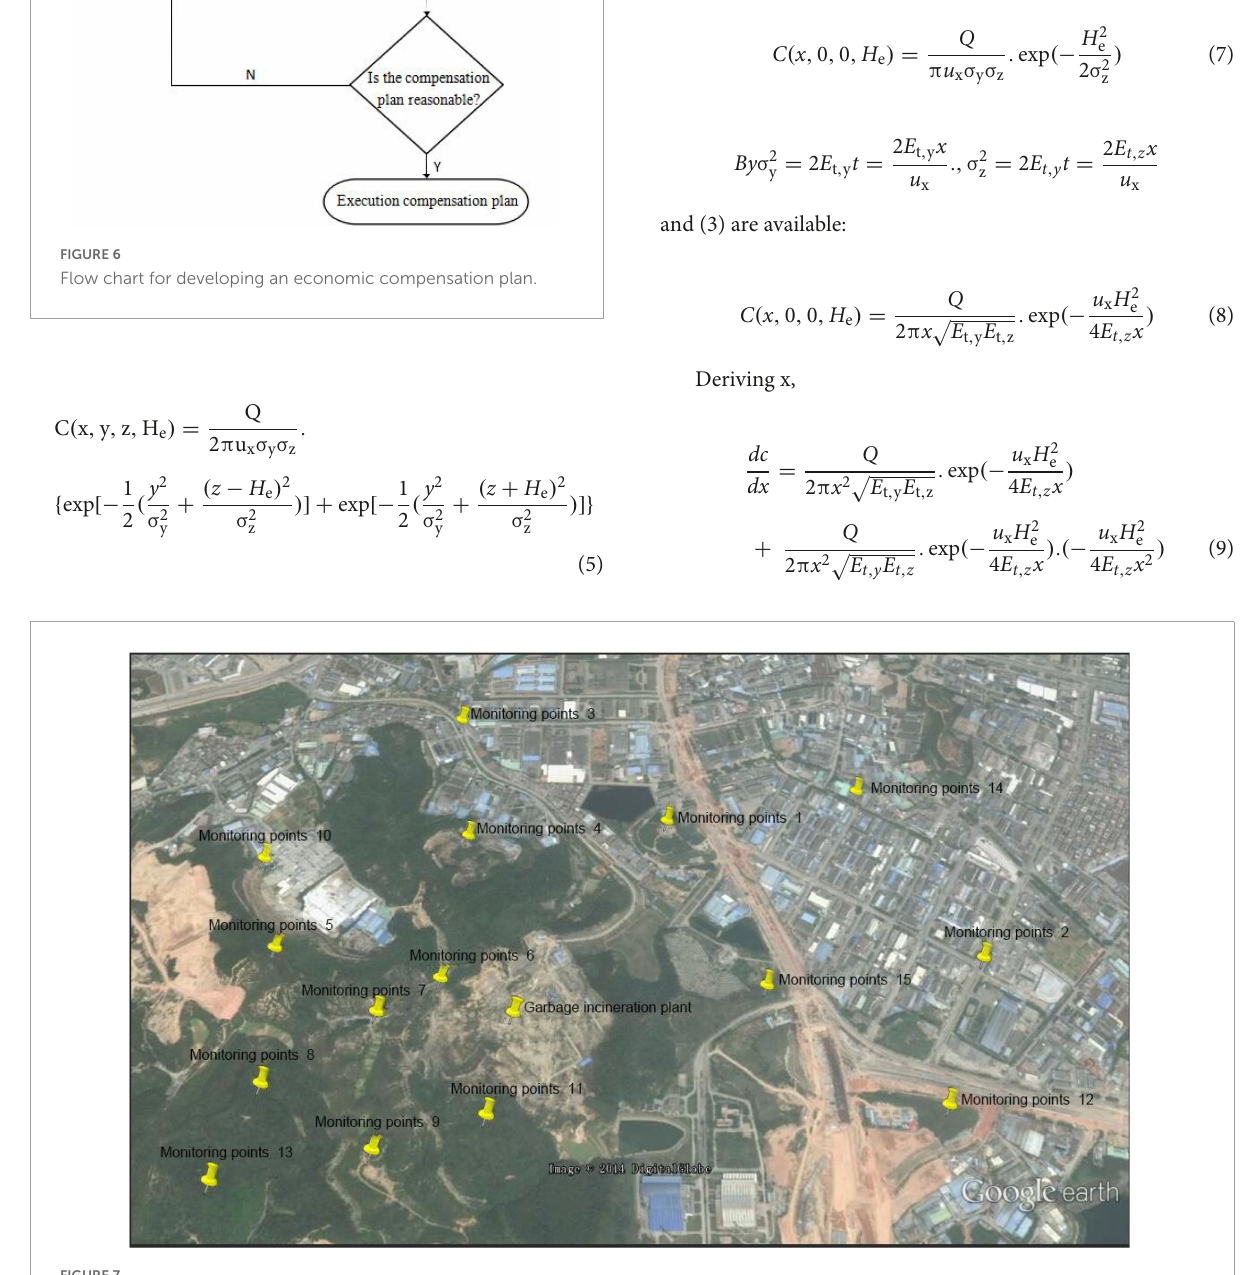
FIGURE7 Location of monitoring